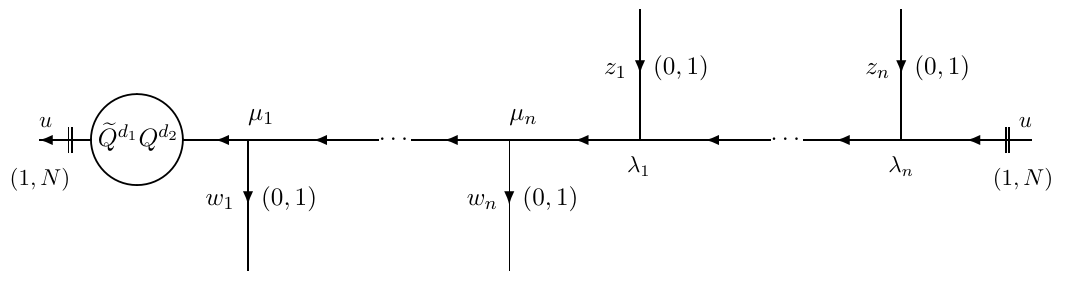
Figure 3 . Diagram representing the trace G n ( ~z, ~w | ~λ, ~µ ) . The left and the right ends of the horizontal line are